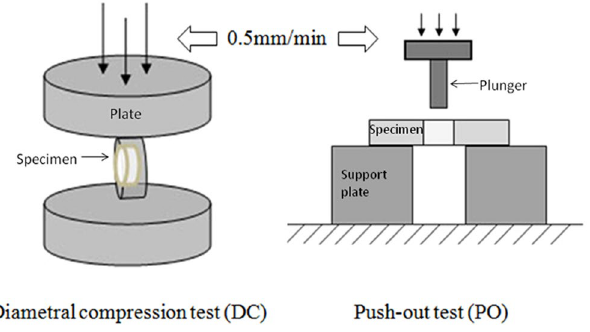
Figure 5. Schematic diagrams of the mechanical tests to determine post-dentin interfacial bond